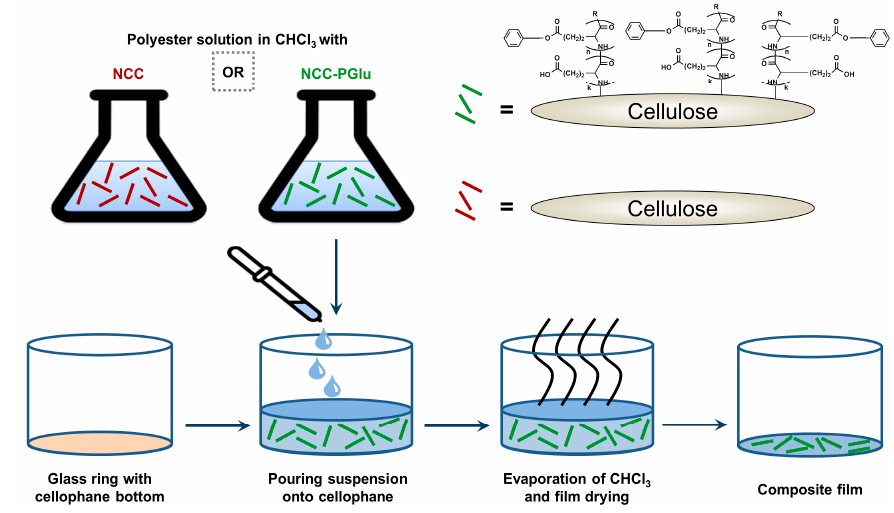
Figure 2. General scheme for the preparation of composite films.